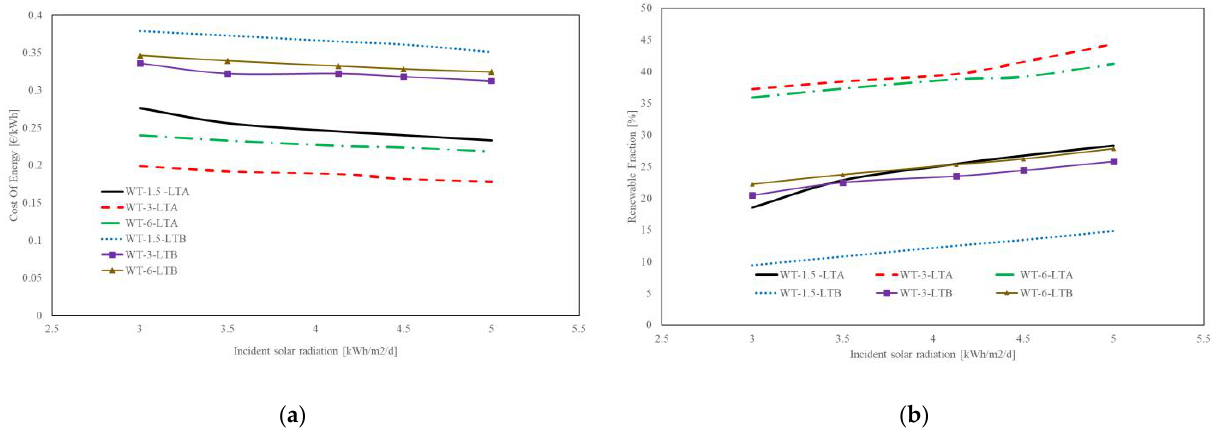
Figure 10. Solar potential parametric study for the wind pattern 2 for different wind turbines. ( a ) COE vs. solar potential; ( b ) Ren.Fr. vs. solar potential.